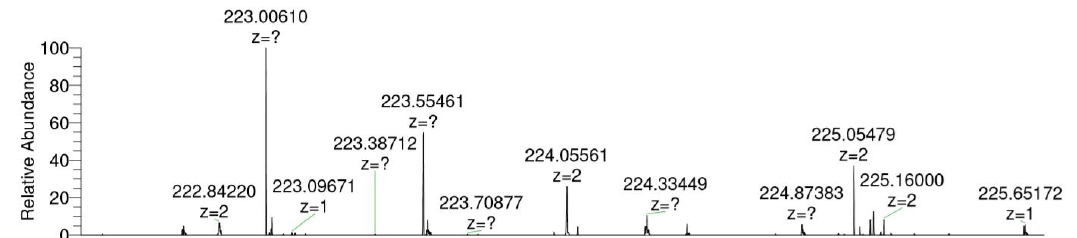
Figure 2. Mass spectrum of 1-naphthyl sulfate produced from 1-naphthol by enzyme bag biotransformation with human SULT4A1 (C 10 H 8 O 4 S, [M–H] – theor. = 223.00705, [M–H] – exp. = 223.00610, Δ m /z = 4.26 ppm).